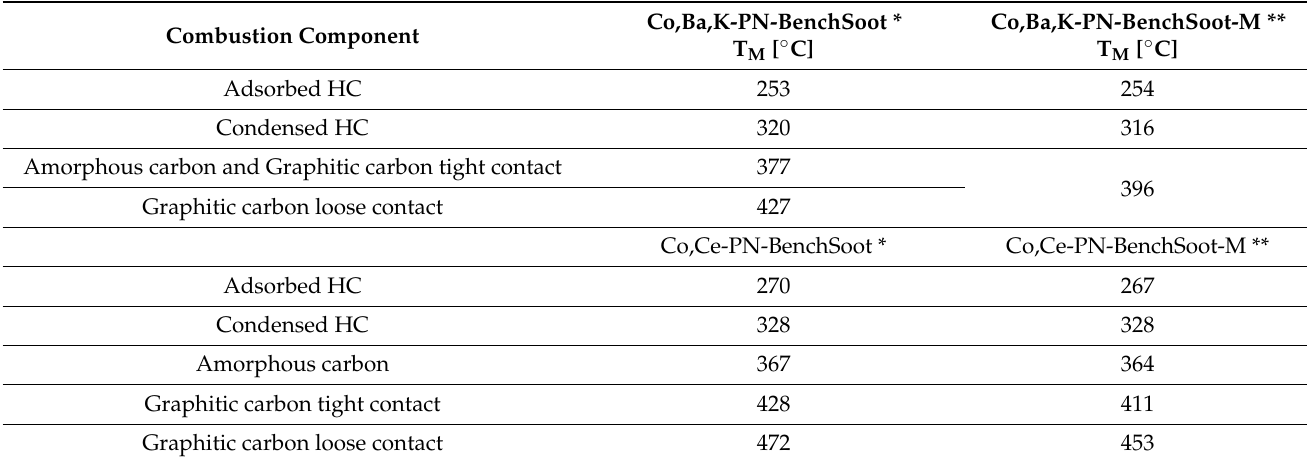
Table 7. Temperatures of maximum soot combustion rates on catalytic ceramic papers with BenchSoot (obtained from Figure 10). Effect of soot-to-catalyst contact.